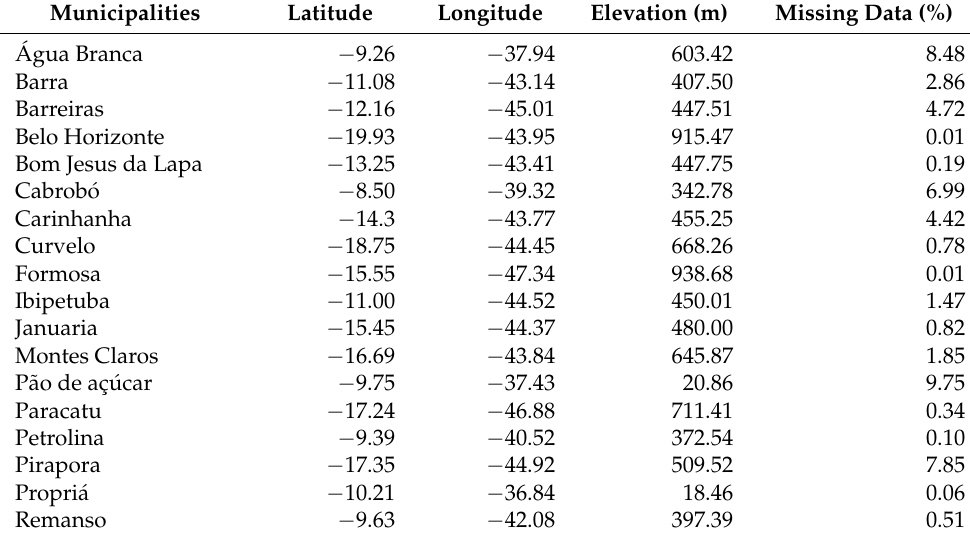
Table 1. Information about the surface